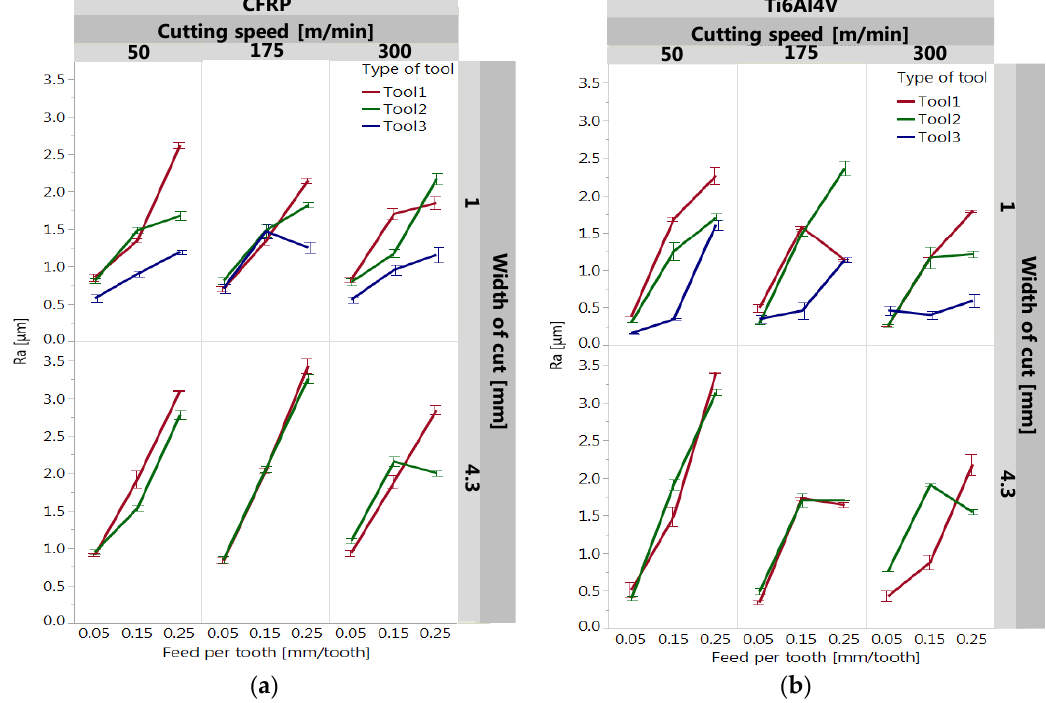
Figure 21. Arithmetic mean value (Ra) according to the different cutting parameters using ±standard error of the mean: ( a ) [0] 8 plaque; ( b ) Ti6Al4V plaque.